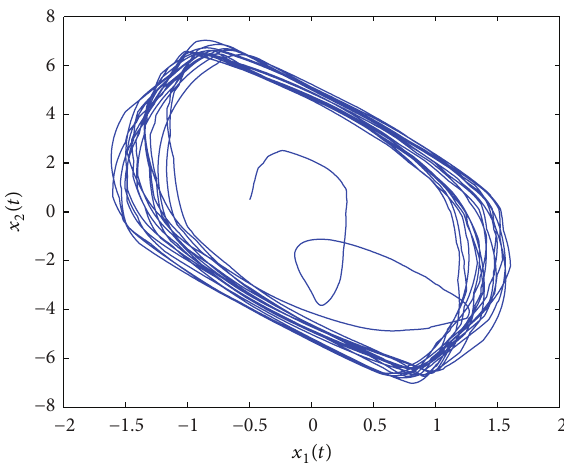
Figure 1: Chaotic behavior of master system (3) with 𝑢(𝑡) = 0 .